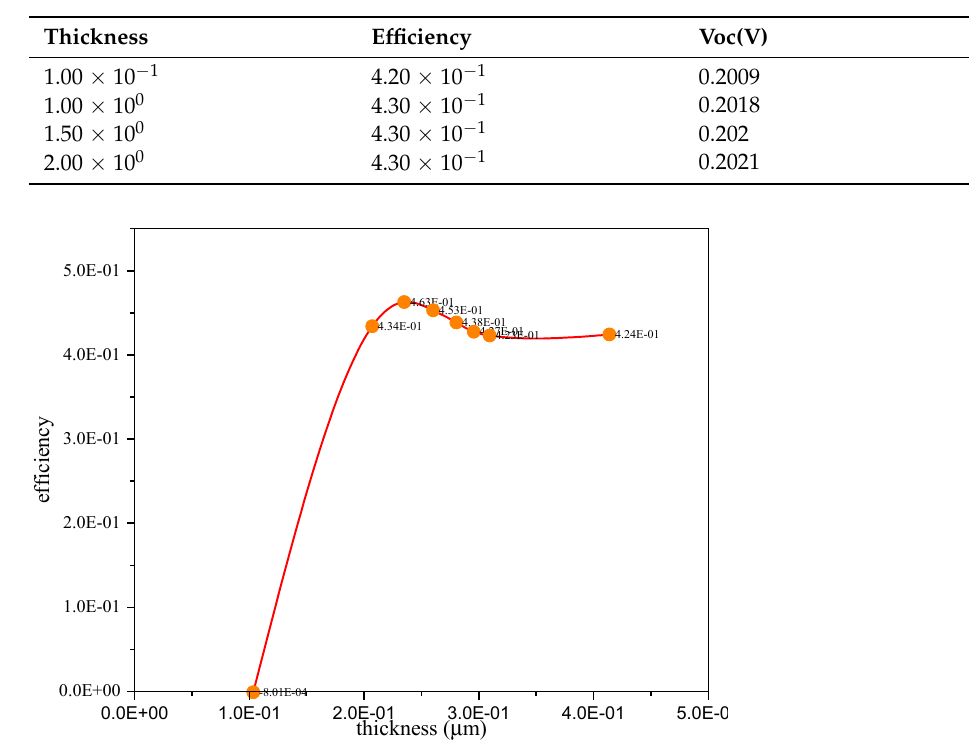
Table 3. Effect on efficiency and Voc with thickness.